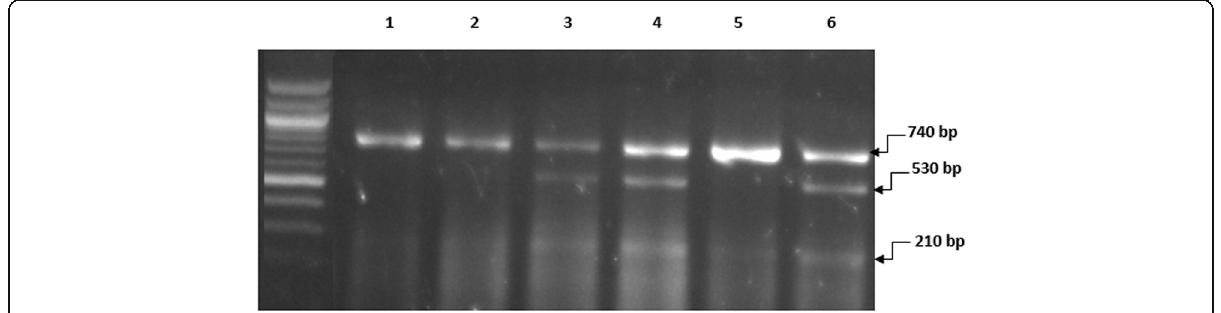
Fig. 1 The genotypes of VDR gene polymorphism using ApaI restriction enzyme, 100-bp DNA marker (NEB). Lanes 1, 2, and 5: ApaI with homozygote genotype; uncleaved ApaI site fragment 740 bp. Lanes 3, 4, and 6: ApaI with heterozygote genotype; heterozygosis fragments 740, 530, and 210